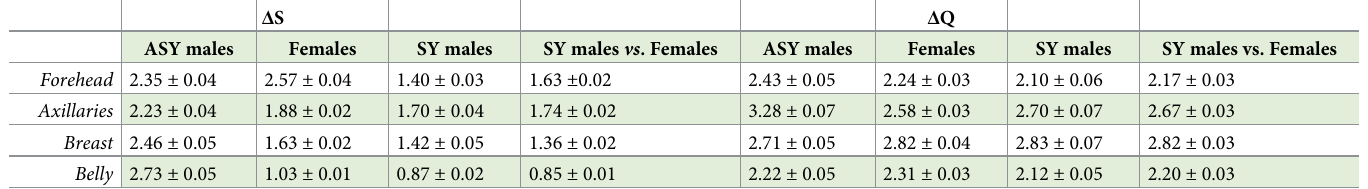
Table 2. Chromatic and achromatic distances of reflectance spectra among after second-year males, females and second-year males, and between second-year males and females. Mean ± s . e . of just noticeable differences (JNDs). Δ S Δ Q ASY males Females SY males SY males vs . Females ASY males Females SY males SY males vs. Females Forehead 2.35 ± 0.04 2.57 ± 0.04 1.40 ± 0.03 1.63 ± 0.02 Axillaries 2.23 ±